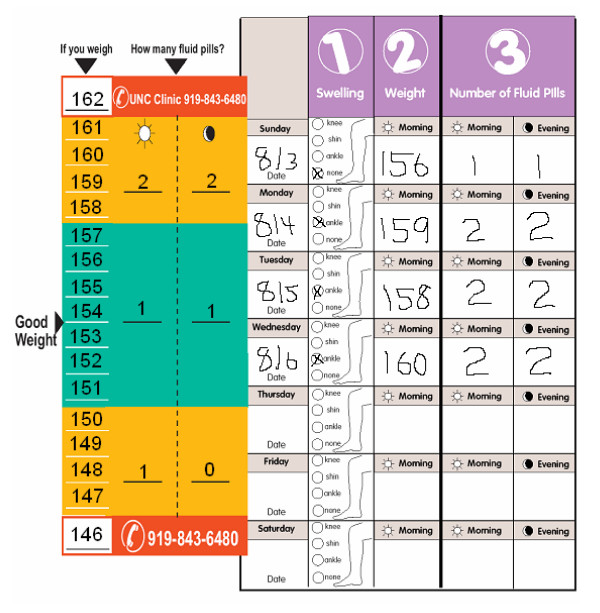
Sample heart failure management plan for a patient.